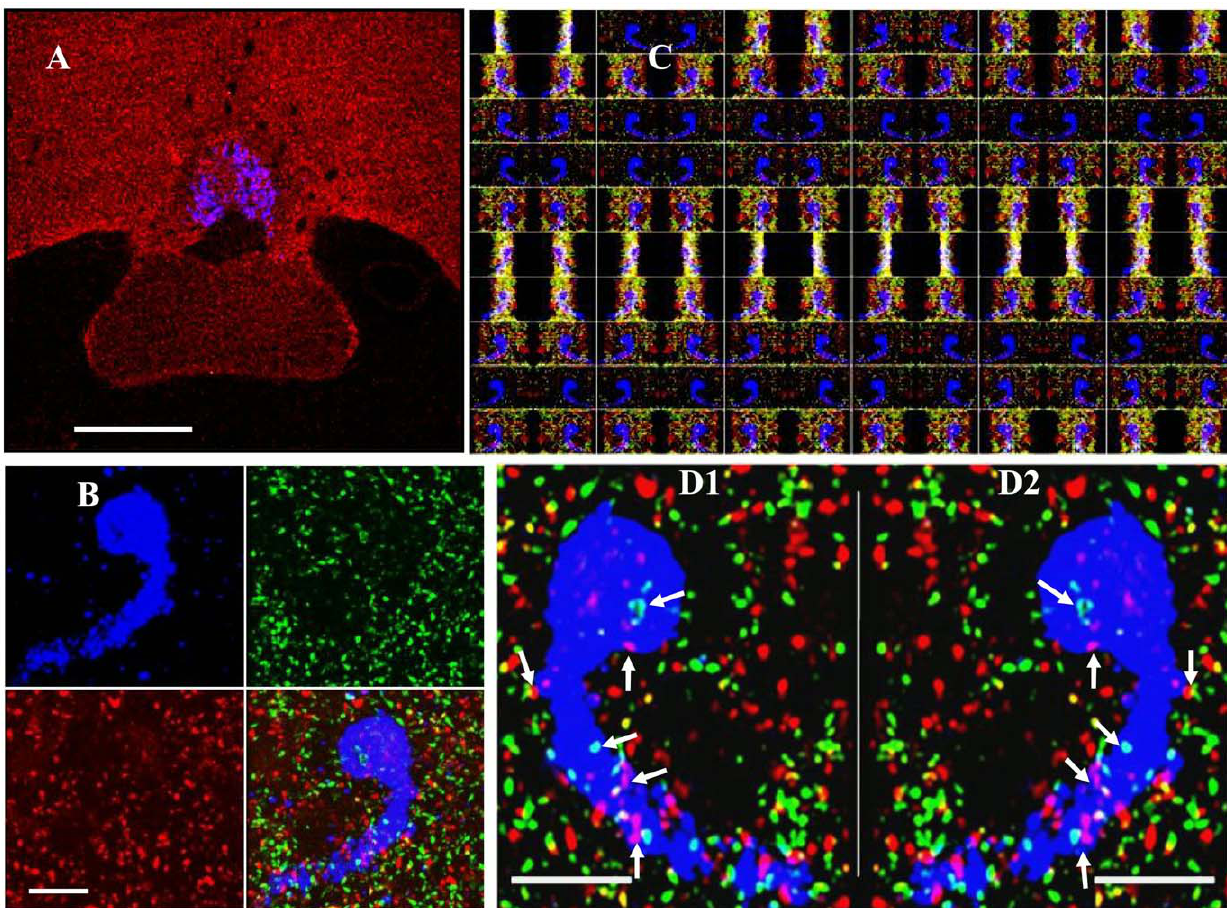
Figure 2. Organization of VGAT and VGLUT2 synaptic terminals onto GnRH neurons. Figure 2A, a low magnification confocal image of the brain section, encompassing POA regions, stained for VGAT (red), GnRH (blue) and VGLUT2 (green; channel hidden for clarity). Figure 2B is a 3D confocal image created using Z-stacks. Figure 2C shows stereo views of a single GnRH neuron in various projections (60 projections). Figures 2 D1 and D2 show magnified stereo images of a GnRH neuron and organization of VGAT (red) and VGLUT2 (green) synaptic terminals. A synaptic terminal apposing GnRH neuron was confirmed and counted only when it apposed the cell body and dendrite (white arrows) throughout the rotation of the cell in multiple fields around Z axis. Scale bars represent 50 m m in Figure 2A, and 10 m m in Figure 2B and D.